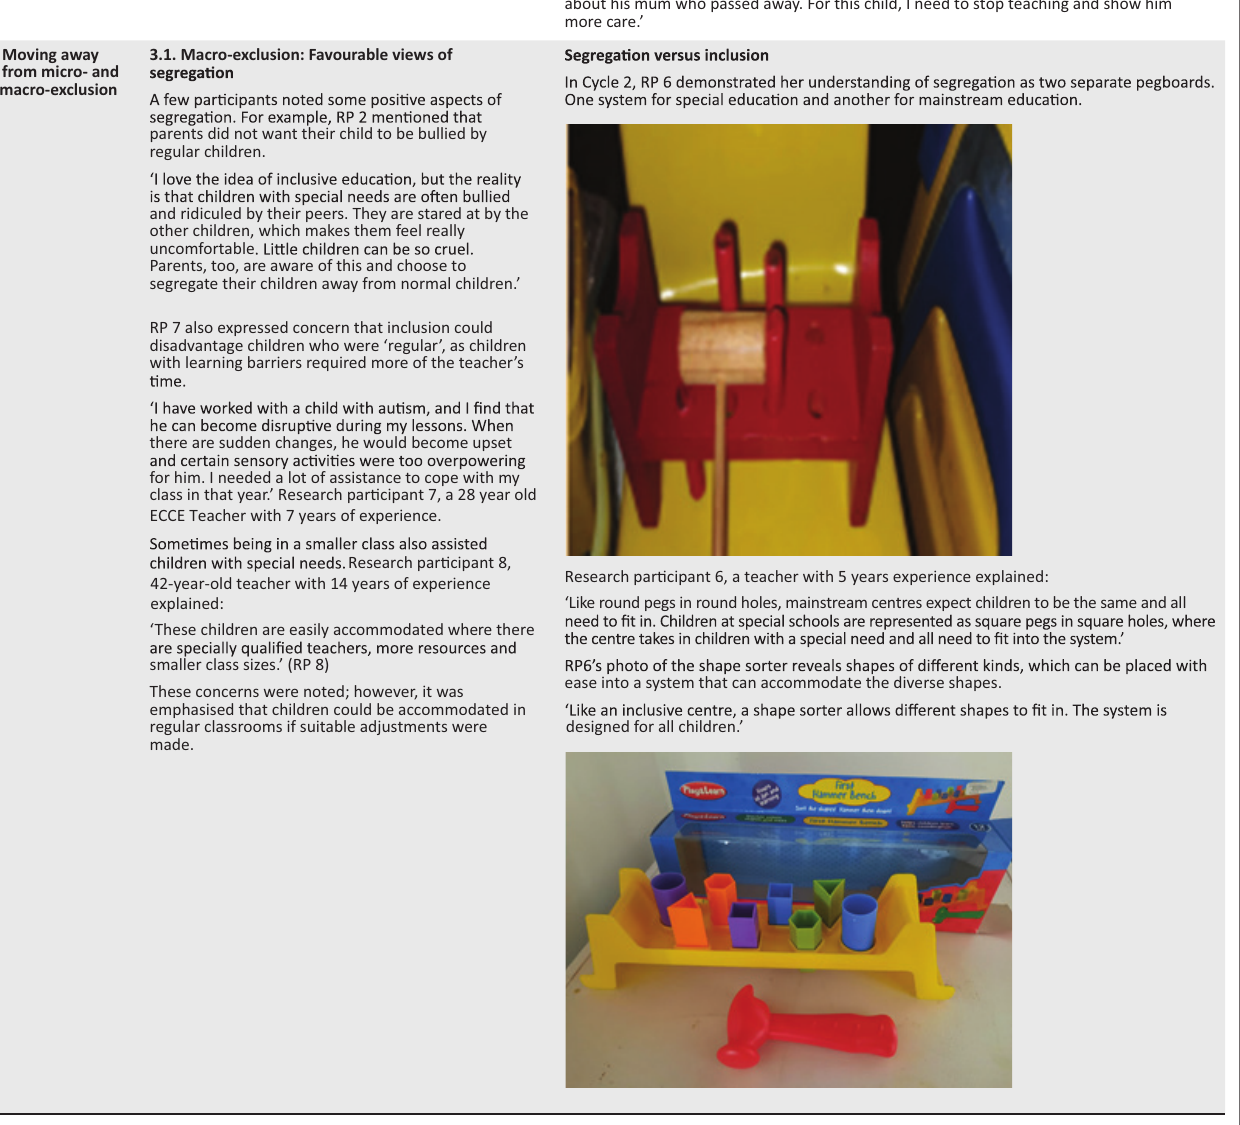
FIGURE 1 (Continues...): Participants’ photovoice, captions and narratives for cycles 1 and